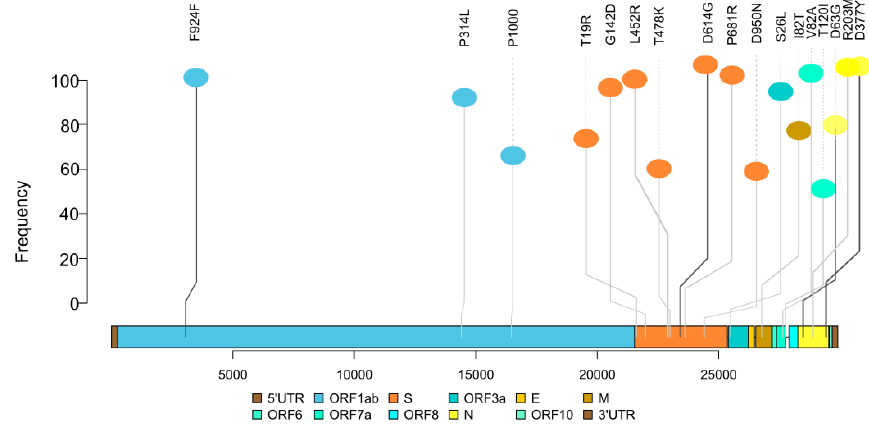
Figure 3. Prevalence of B.1.617.2 variants in post-vaccinated samples.